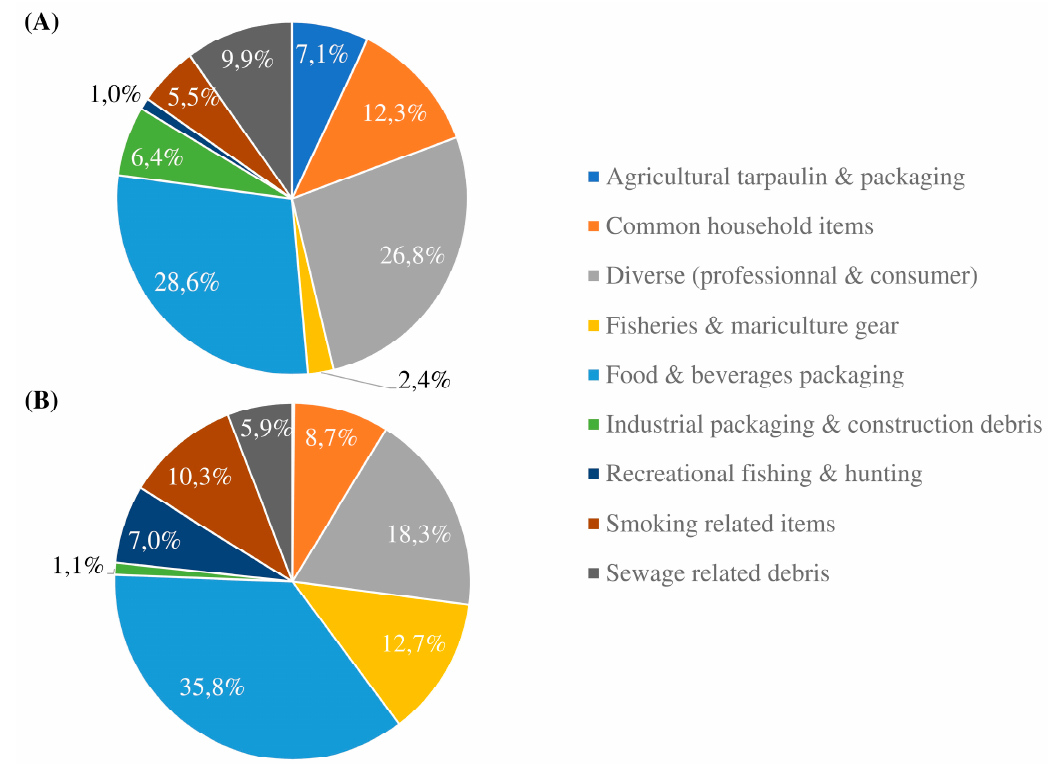
Figure 3. ( A ) Inland litter composition in term of uses, ( B ) Beached litter composition in term of uses.